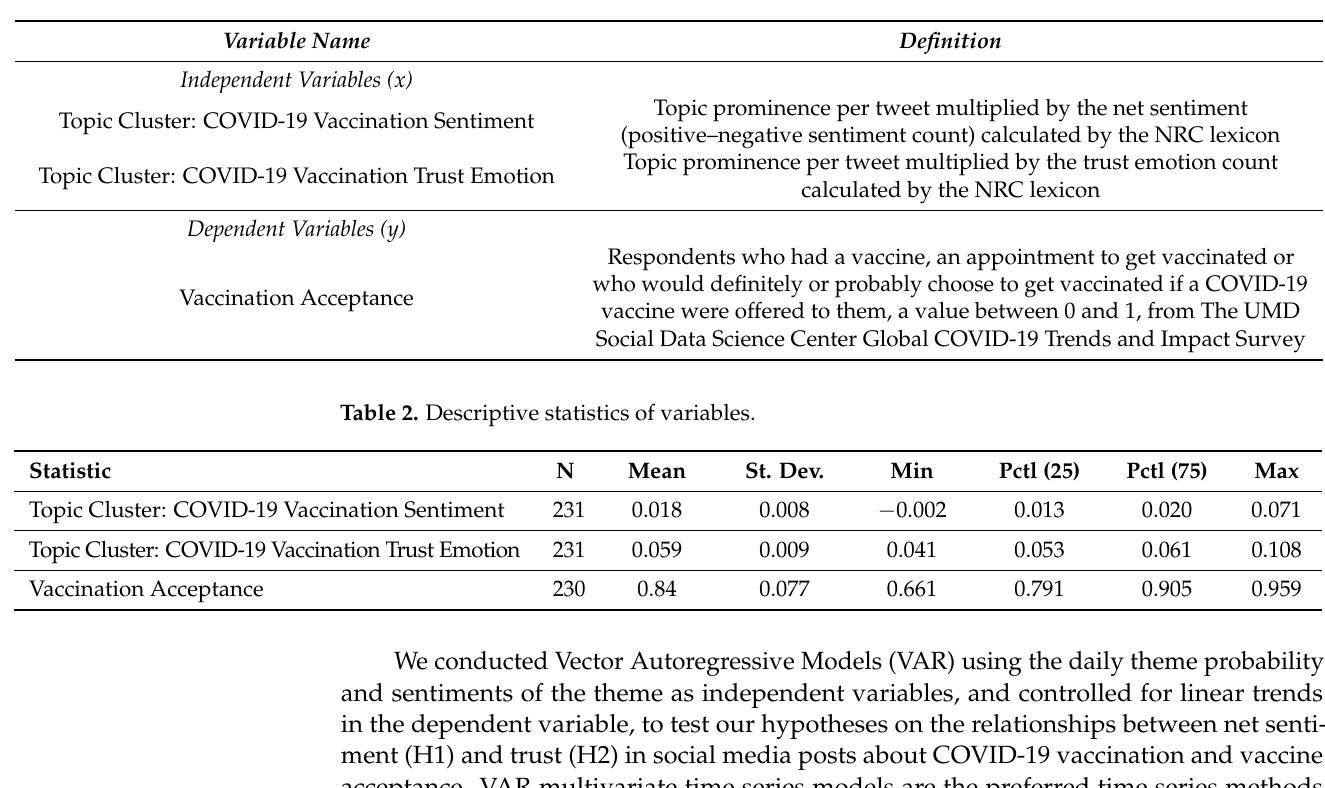
Table 1. Variables and definitions.